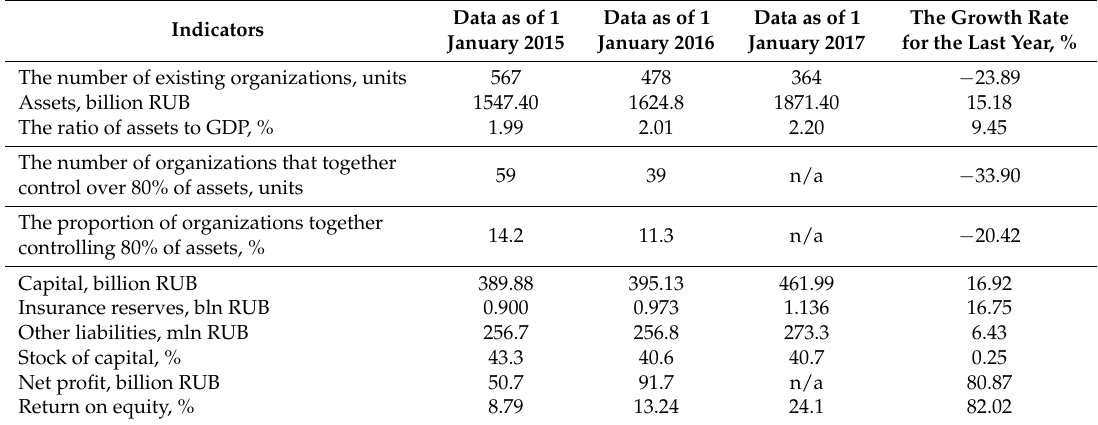
Table 1. Main economic indicators of insurance organizations in Russia. GDP—gross domestic product.